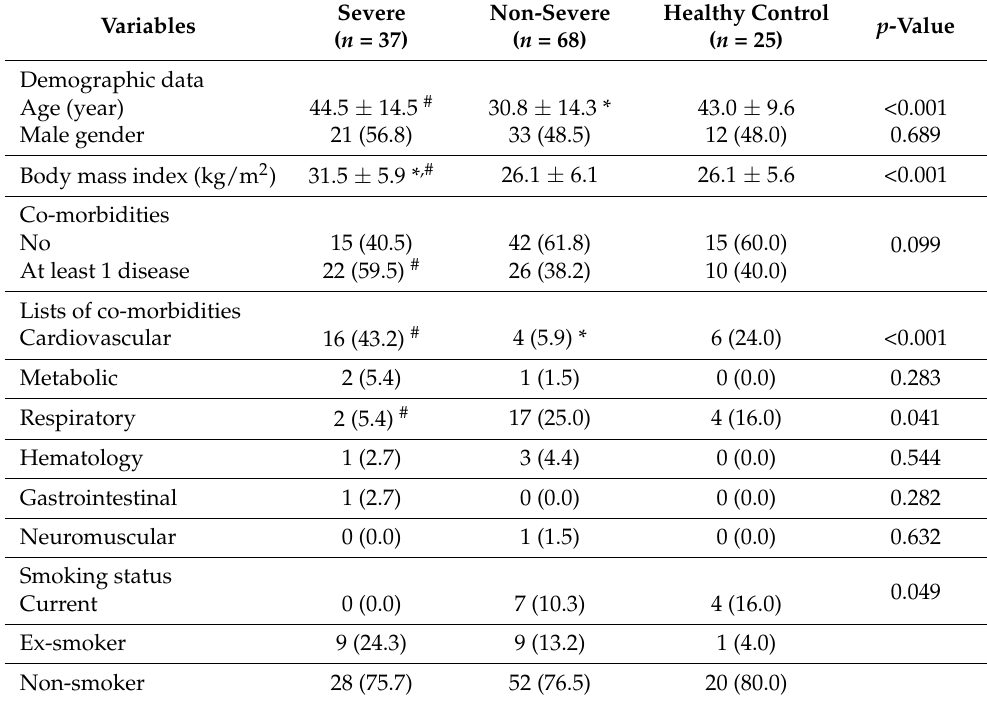
Table 1. Demographic data of study population ( n = 130).